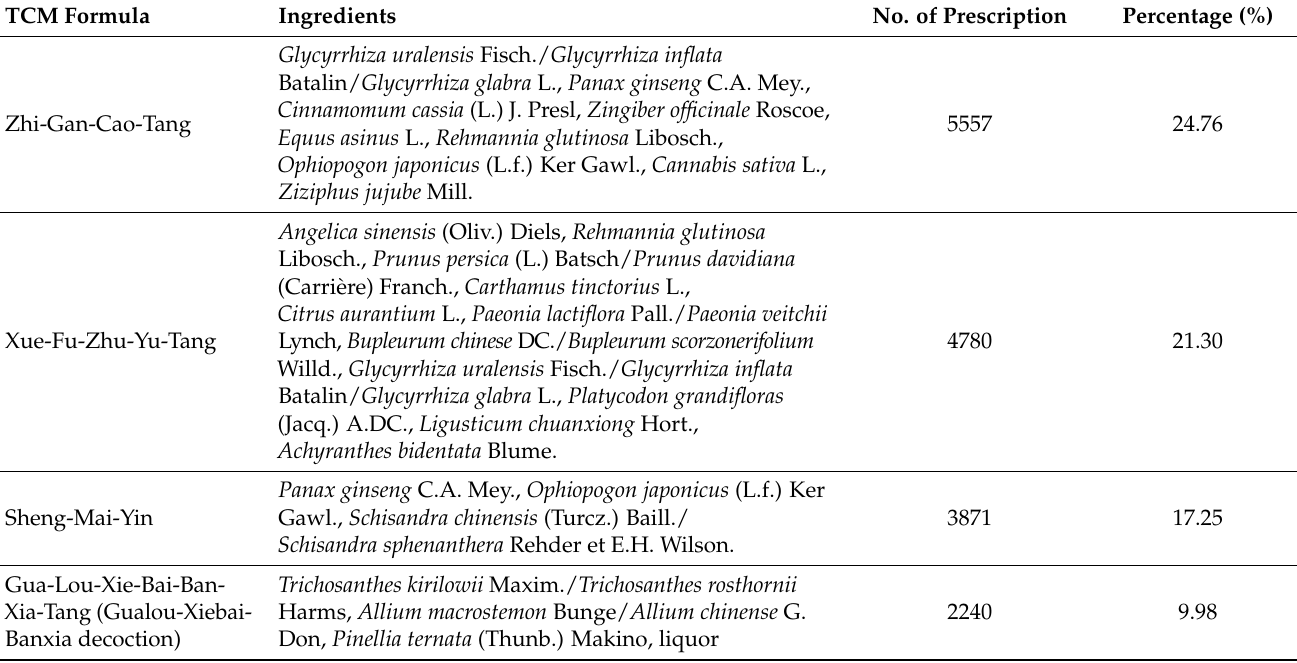
Table 4. The most prescribed 10 TCM formula for IHD in Taiwan during 2000–2017 (total prescription number, n =